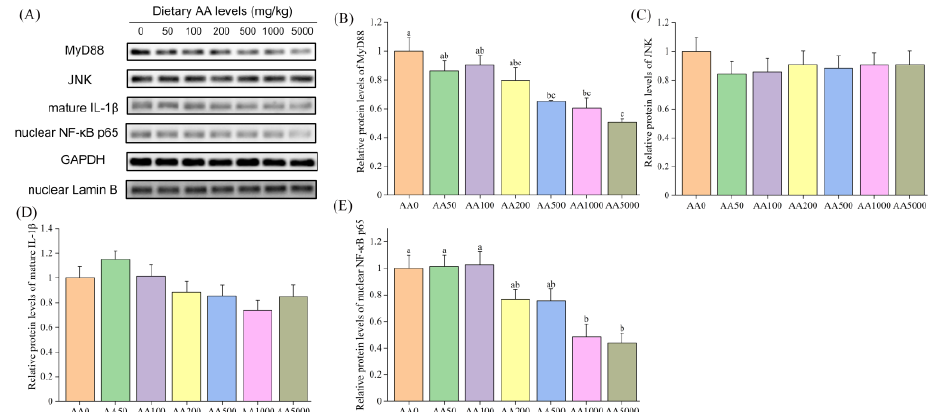
Figure 3. Protein expressions of MyD88, JNK, mature IL-1β and nuclear NF-κB p65 in the gill of abalone ( Haliotis discus hannai ) after a 100-day feeding trial. ( A ) Representative Western Blot image of MyD88, JNK, mature IL-1β and nuclear NF-κB p65; ( B – E ) Protein expressions of MyD88, JNK and mature IL-1β and nuclear NF-κB p65. All data were expressed as mean ± SE ( n = 3). The different lowercase letters indicate significant differences ( p < 0.05). Expressions of β-defensin , mytimacin 6 and arginase-I in the digestive gland and gill of abalone are given in Table 10. The levels of β-defensin and arginase-I in the digestive gland were significantly increased after dietary AA ( p < 0.05), whereas the expression of mytimacin 6 was not affected by dietary AA ( p > 0.05). In contrast, the mRNA levels of β-defensin and arginase-I in the gill were not significantly different, and the expression of mytimacin 6 was significantly upregulated by dietary AA ( p < 0.05). Table 10. Expression levels of β-defensin , mytimacin 6 and arginase-I in the digestive gland and gill of abalones ( Haliotis discus hannai ) after a 100-day feeding trial.